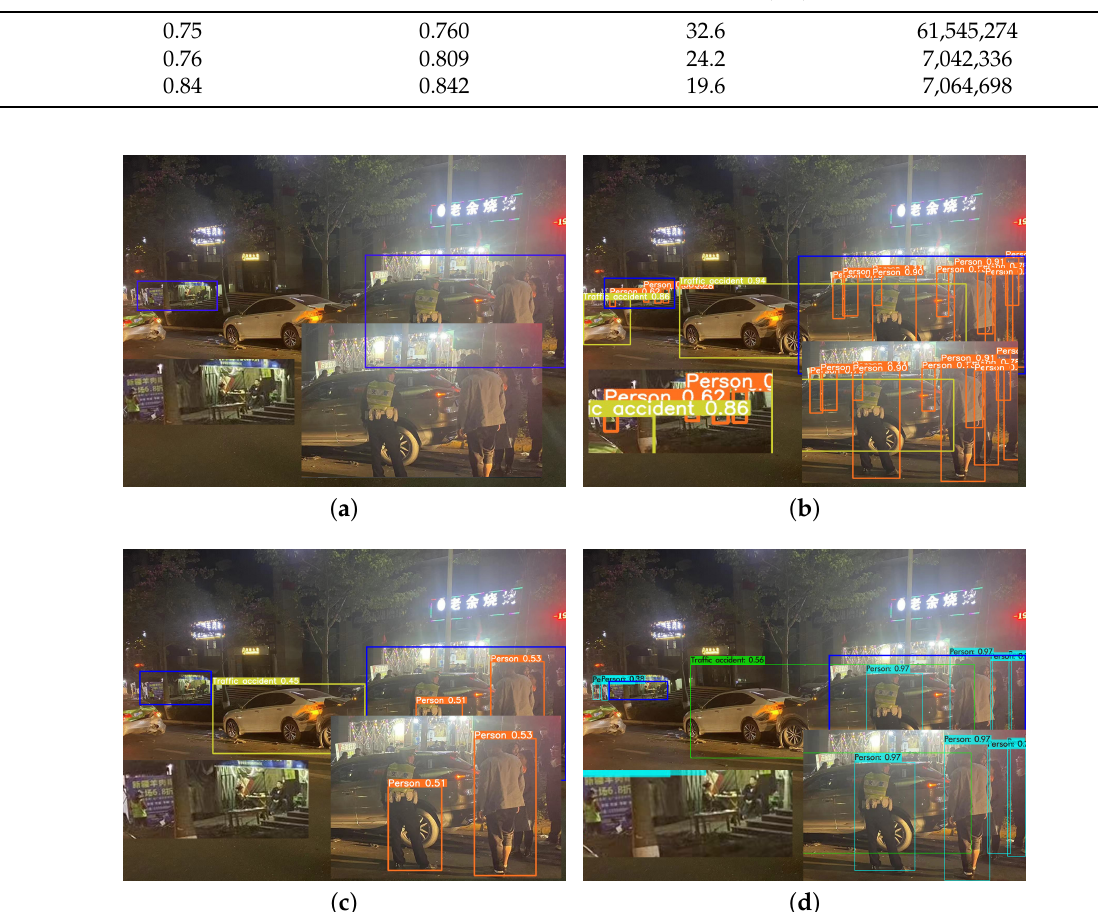
Figure 11. The detection effect of complex environment at night. Where ( a ) shows the original figure; ( b ) shows our proposed improved YOLOv5s network detection effect; ( c ) shows YOLOv5s detection effect; ( d ) shows YOLOv3 detection